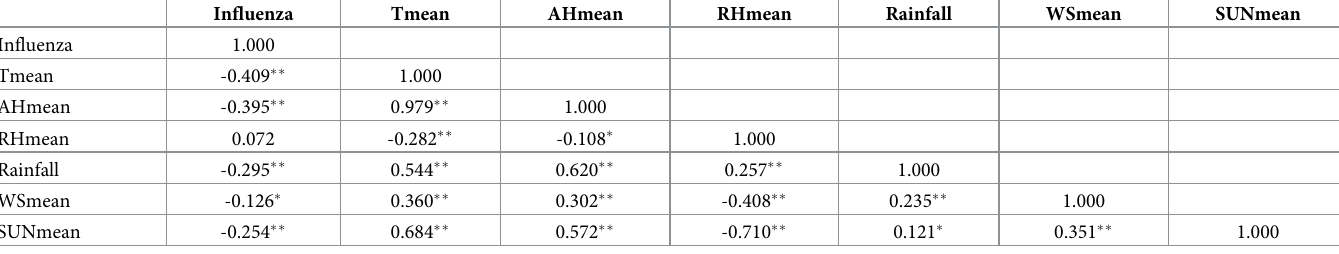
Table 2. Spearman’s correlation results between weekly meteorological variables and confirmed influenza cases every ten thousand outpatient visits in Chongqing, China, 2012–2019.